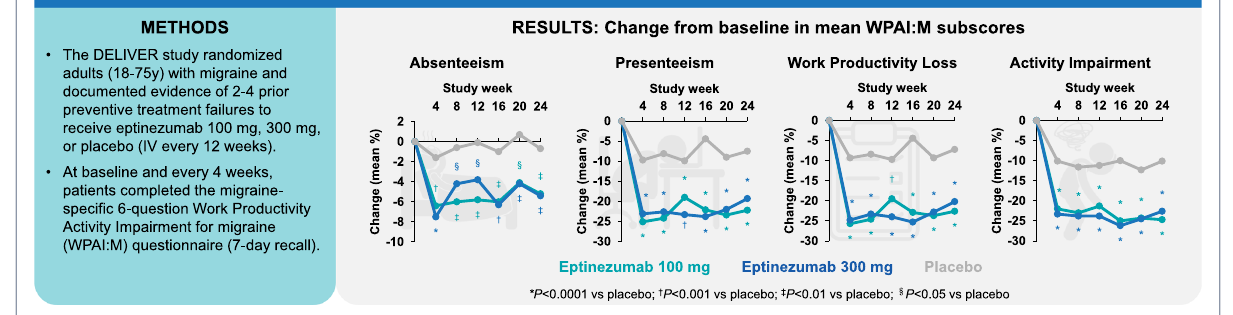
Conclusion: In adults with migraine and prior preventive treatment failure, eptinezumab 100 mg and 300 mg IV every 12 weeks improved absenteeism, presenteeism, work productivity loss, and activity impairment more than placebo. Trial registration: Clini calTr ials. gov (Identifier: NCT04 418765); EudraCT (Identifier: 2019–004497-25) (https:// www. Graphical Abstract Eptinezumab improves self-reported work productivity in patients with migraine and prior preventive treatment